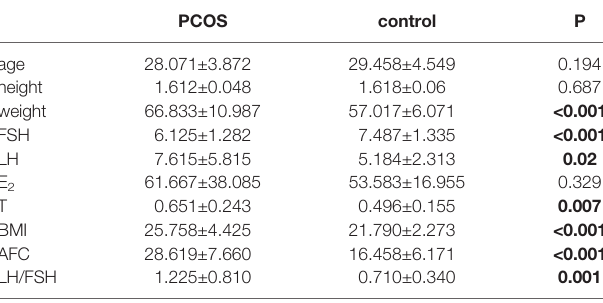
TABLE 1 | Clinical epidemiological information of all the volunteers.